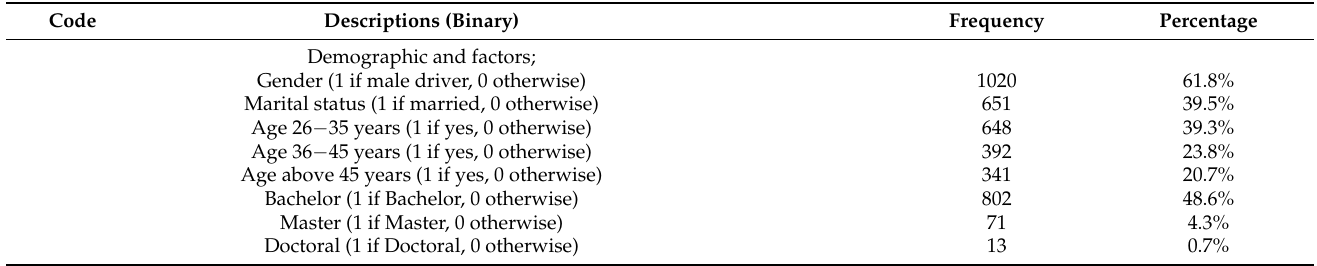
Table 2. Descriptive statistics of drivers’ socio-demographics and factors associated with the TPB and HAPA (n =